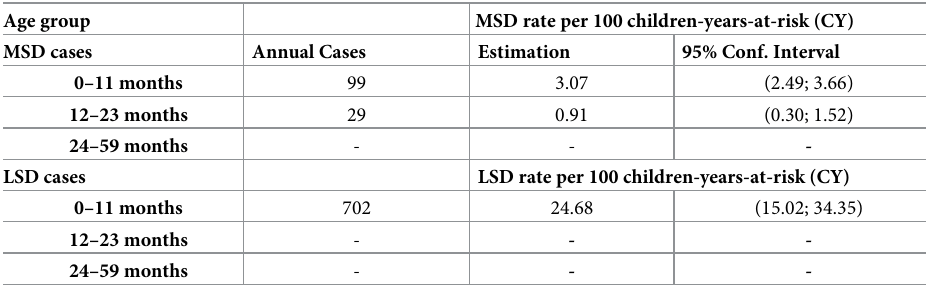
Table 3. Rotavirus incidence rate by age group among MSD and LSD